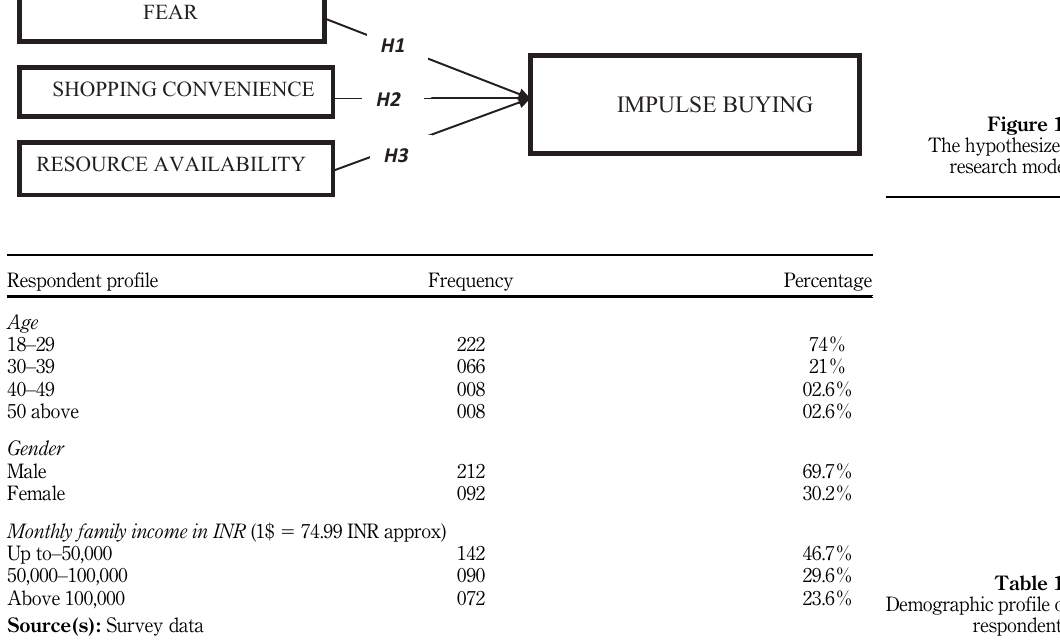
Figure 1. The hypothesized research